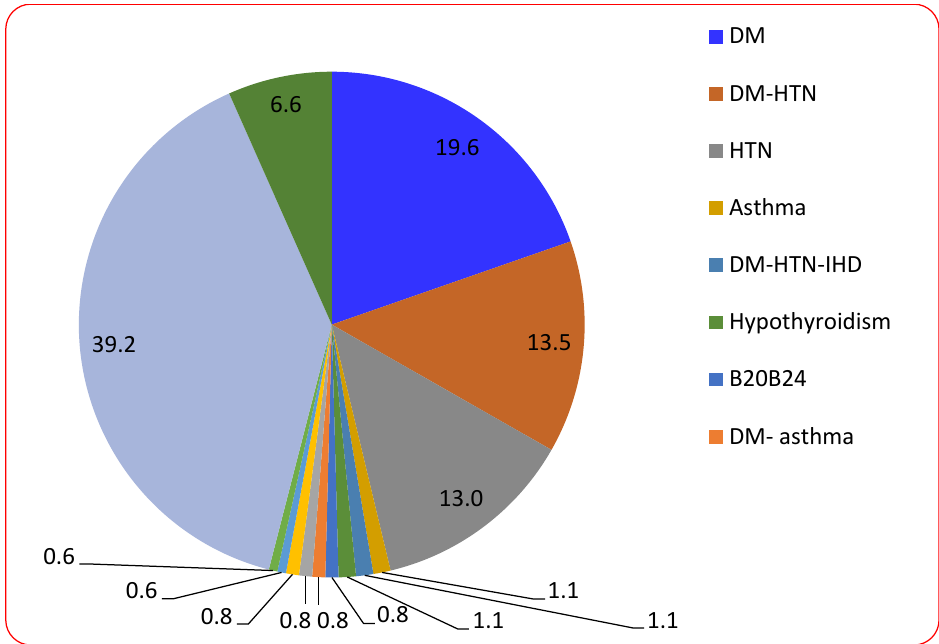
Figure 1. The most important chronic diseases of the participating patients.